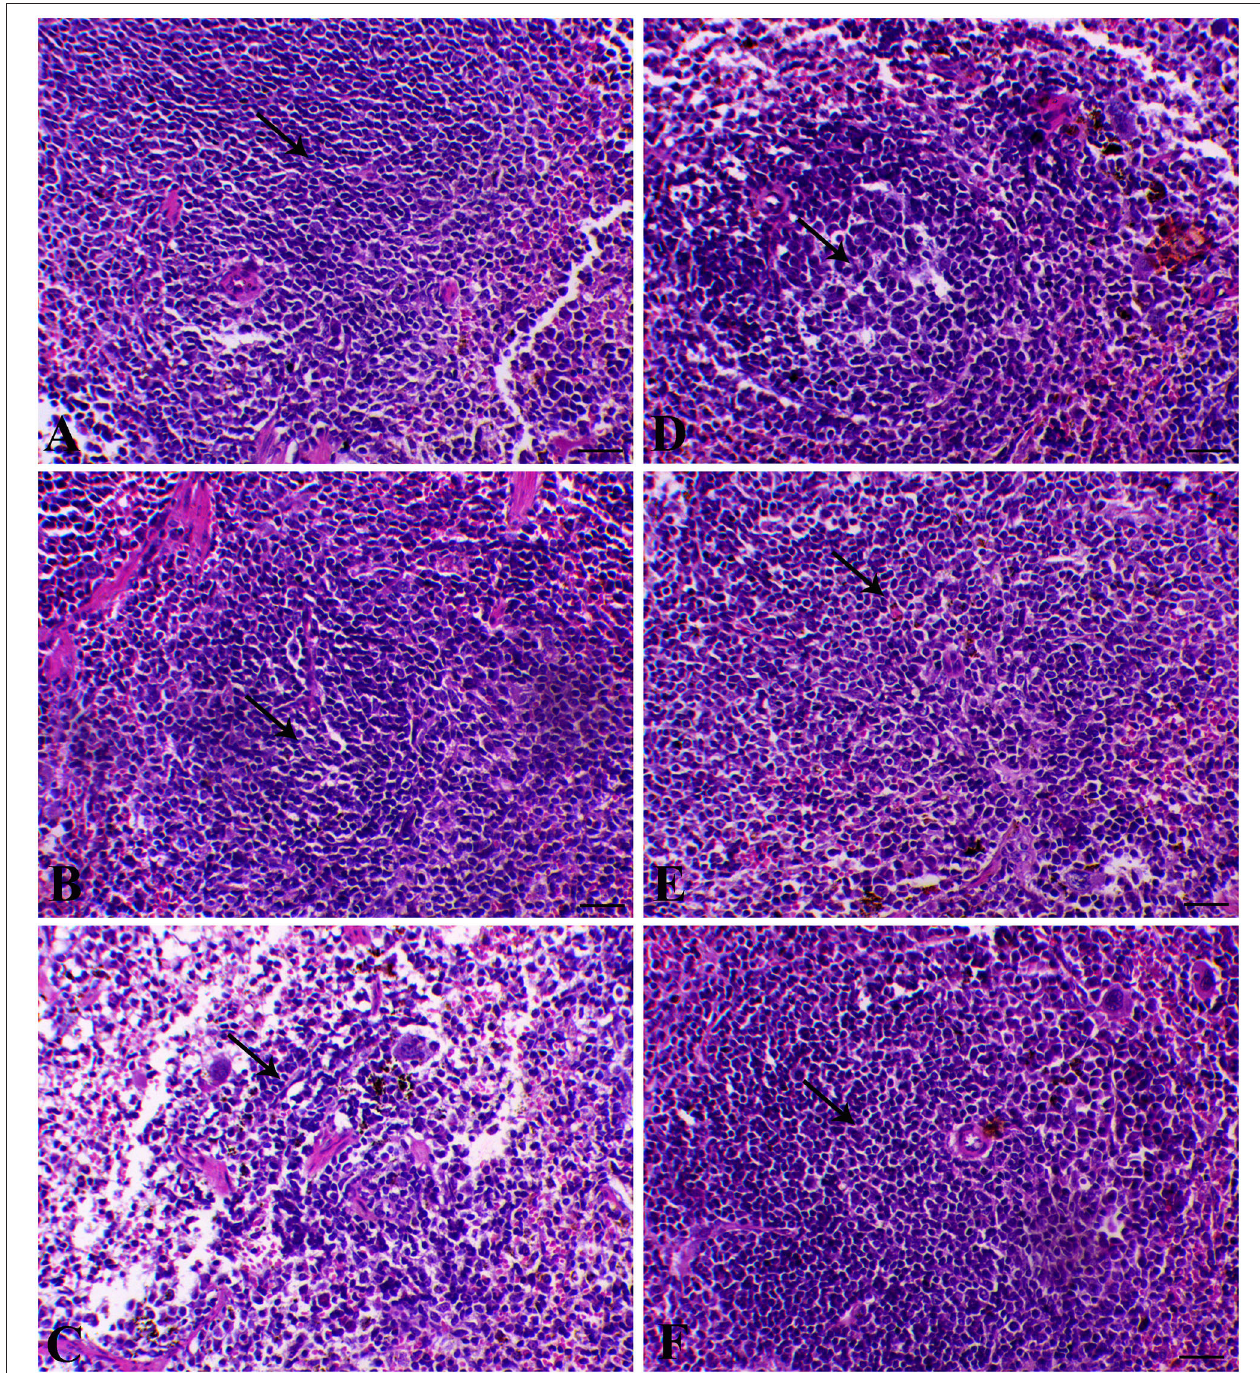
FIGURE 7 | Splenic histological sections of control group (A) (arrow indicates normal lymphoid follicle), SP–MGT group (B) (arrow indicates normal lymphoid follicle), Infected group (C) (arrow indicates severe degree of lymphoid depletion), SP-infected group (D) (arrow indicates plenty of lymphoid cells), MTG-infected group (E) (arrow indicates an increase of lymphoid elements), and SP + MGT-infected group (F) (arrow indicates normal lymphoid pulp).